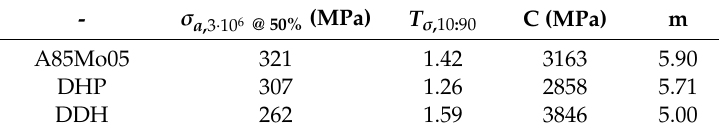
Table 5. Best-fit coefficients of the fatigue curves (Equation (2)).